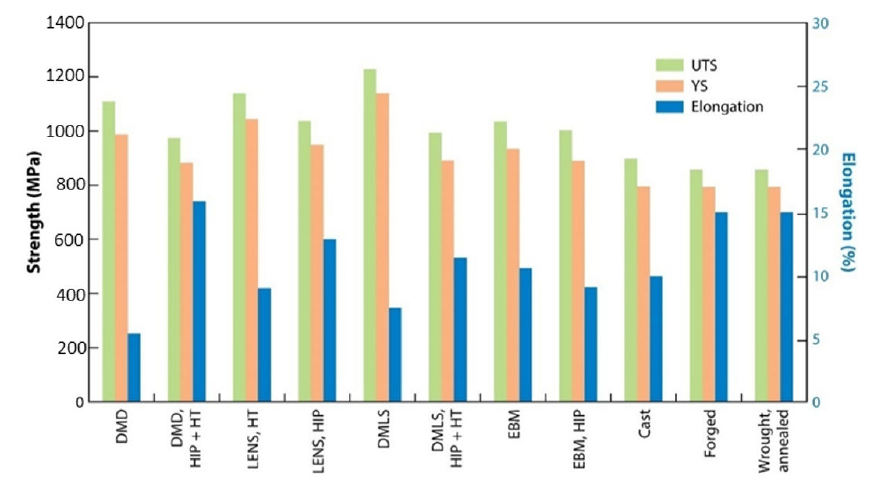
Figure 6. Comparison of mechanical properties for AM-built and Conventional built metallic material Ti-6Al-4V (UTS-ultimate tensile strength, YS-yield stress, DMD-direct metal deposition, LENS-laser engineered net shaping, DMLS-direct metal laser sintering, EBM-electron beam melting; HT-heat treated, HIP-hot isostatic pressing)